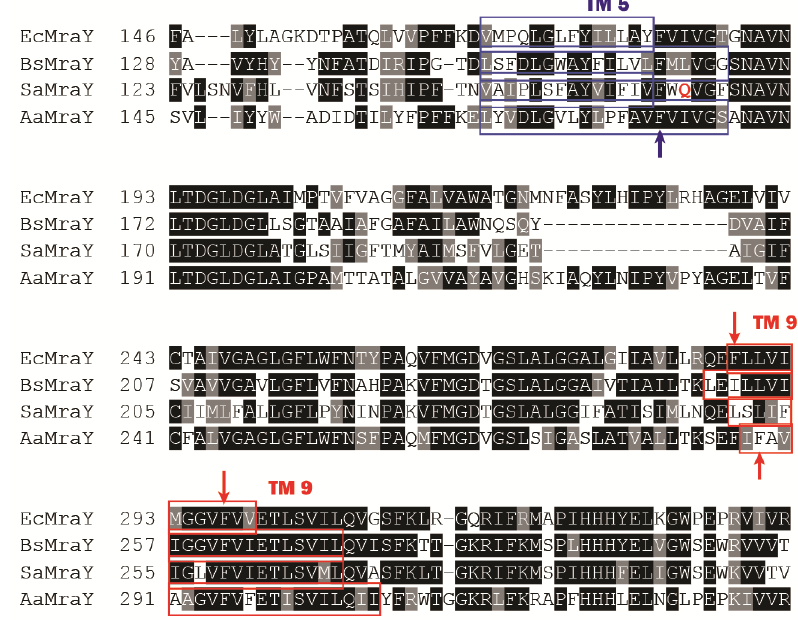
Figure 4. Partial sequence alignment of MraY from four different species (Ec = E. coli ; Sa = S. aureus ; Bs = B. subtilis ; Aa = A. aeolicus ). Some essential phenylalanine residues are indicated with an arrow. The polar Gln residue in S. aureus MraY is marked in red.